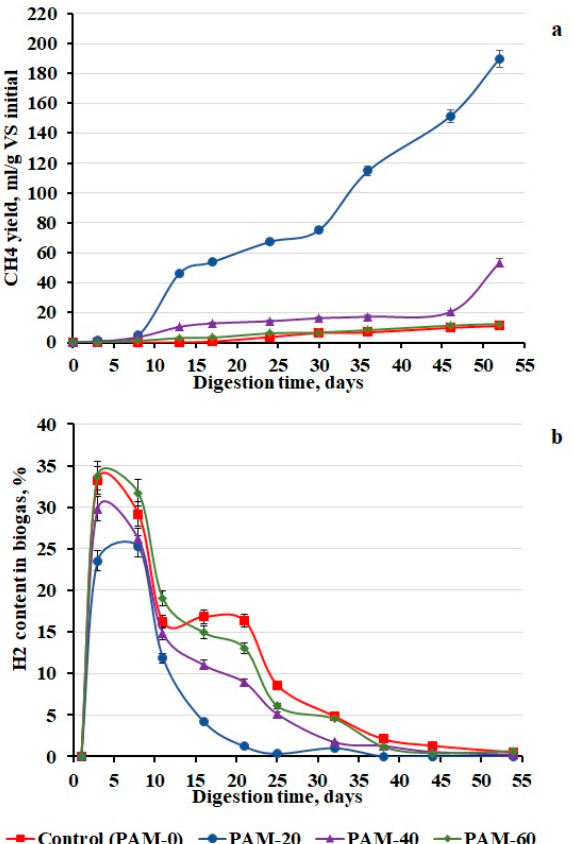
Figure 2. Dynamics of methane accumulation (ml/g VS initial) ( a ) and hydrogen content (%) ( b ) in biogas in bioreactors destabilized due to accumulation of high volatile fatty acid (VFA) concentrations operated without mixing after addition of different polyacrylamide (PAM) concentrations for the restoration of methanogenesis: Control (PAM-0) without the flocculant; PAM-20, PAM-40, and PAM-60, the flocculant concentrations 20, 40, and 60 mg/g TS, respectively. The X-axis begins (0 days) on day 7 of the experiment when the flocculant was added.